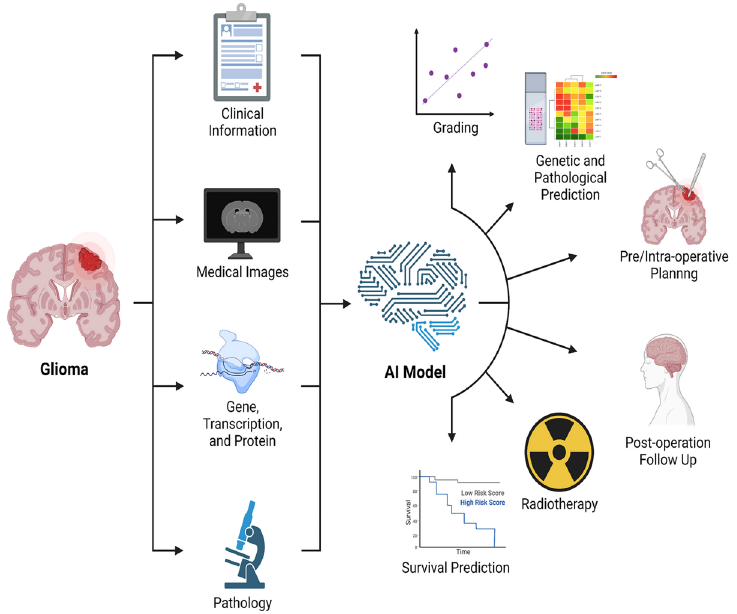
Figure 16. Graphical representation of the main applications of AI in BTs